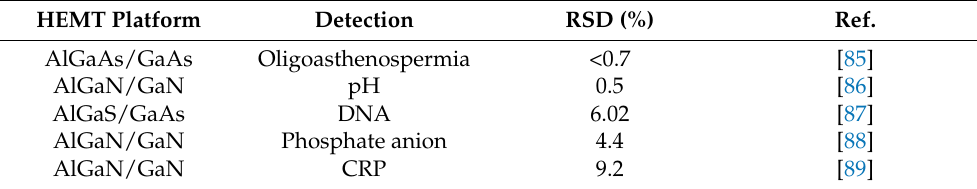
Table 2. Reproducibility rate of HEMT-based biosensor. Relative standard deviation